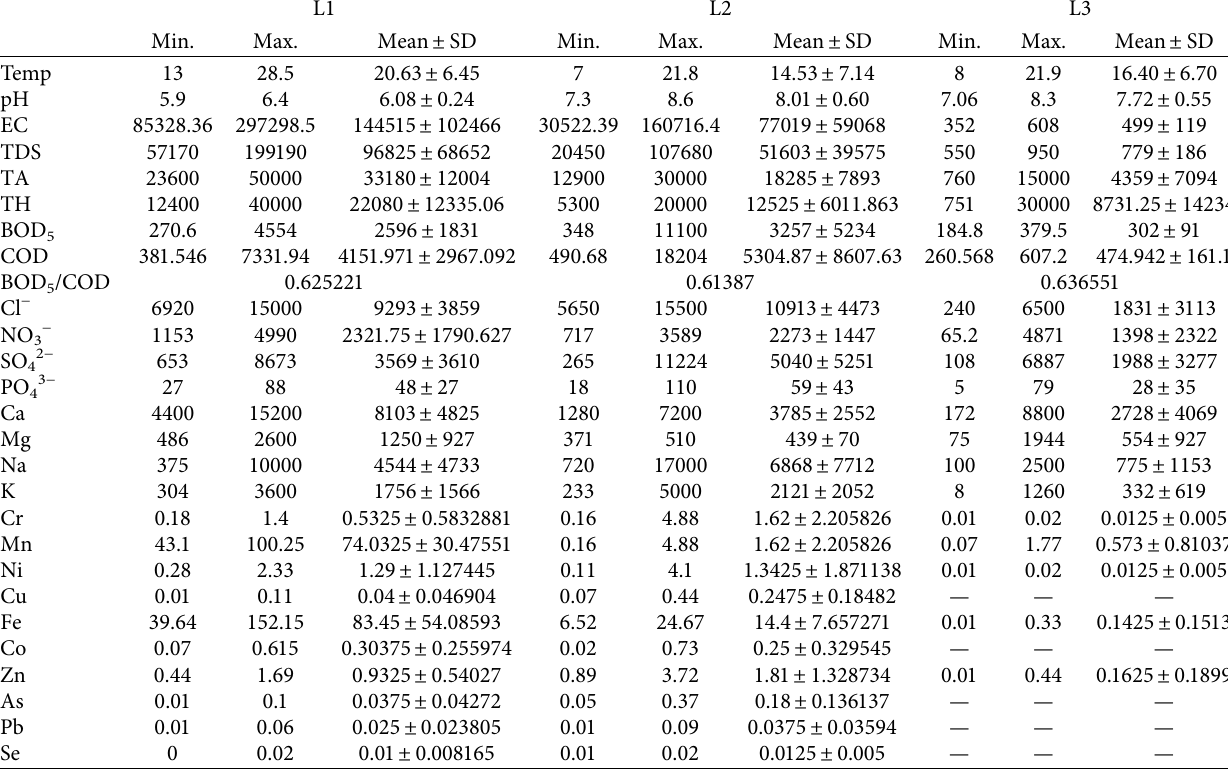
Table 3: Physicochemical parameters of three leachate samples collected from Tanjaro dumping during four seasons during (2021-2022). L1 L2 L3 Min. Max. Mean ± SD Min. Max. Mean ± SD Min. Max. Mean ± SD Temp